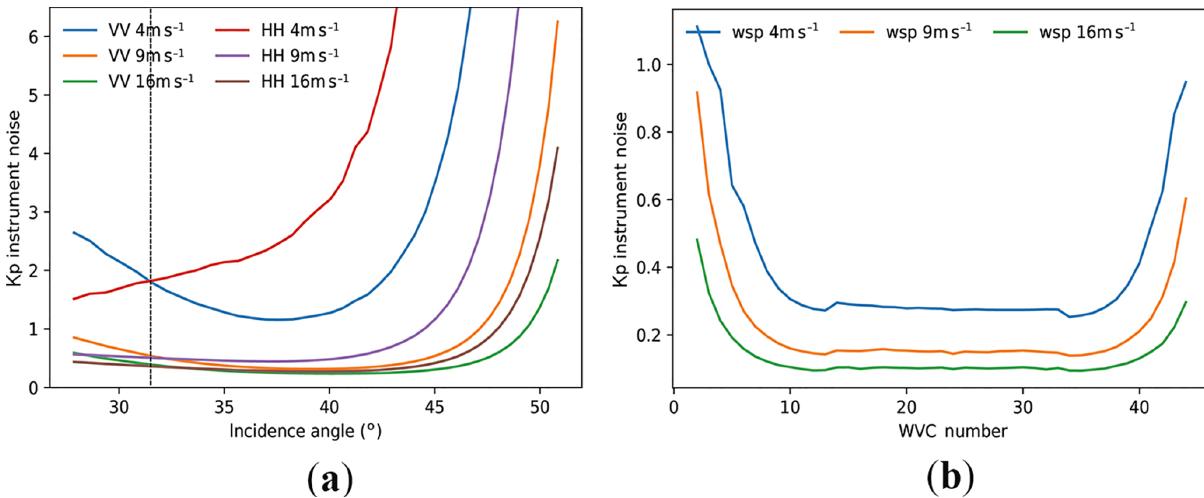
Figure 11. SCAT instrument noise in ratio (1 is 100%) at 4, 9, and 16ms − 1 on (a) slice level and (b) WVC mean Kp.